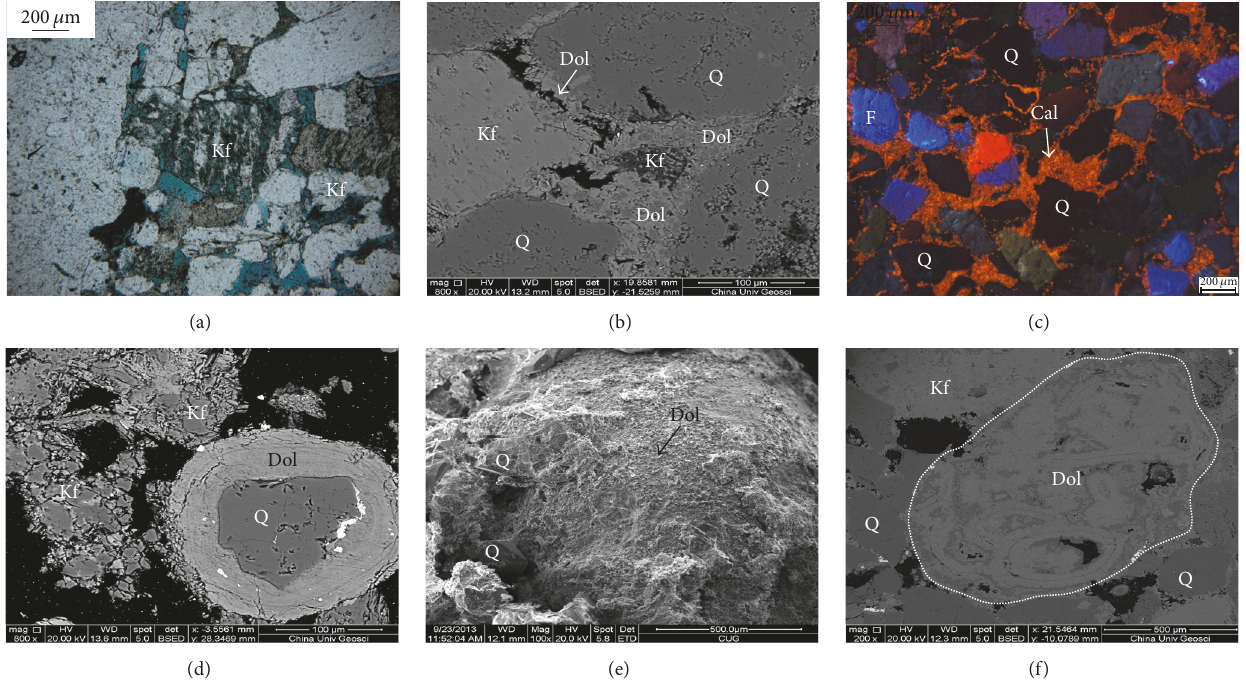
Figure 7: Photomicrographs of feldspar dissolution and dolomite encrustation in the Paleogene sandstone reservoirs in the well BZ-1 of Huanghekou Sag. (a) K-feldspar (Kf) dissolution, E 2 s 1 , 3037 m (9964ft). (b) Backscattered electron (BSE) image of dolomite encrustation, E 2 s 2 , 3084 m (10,118ft). (c) Micrograph of CL showing the calcite cements (orange luminescent), E 2 s 2 , 3084 m (10,118ft). (d) Micrograph of BSE showing dolomite encrustation around the detrital quartz, E 2 s 1 , 3037 m (9964ft). (e) Idem with D but ESEM micrograph, E 2 s 1 , 3037 m (9964 ft). (f) Micrograph of BSE showing dolomite debris (within the white dotted line) and pectinate dolomite encrustation (outside the white dotted line), E 2 s 2 , 3084 m (10,118ft). Cal = calcite, Dol = dolomite, F = feldspar, Kf = K-feldspar, Kln = kaolinite, and Q =